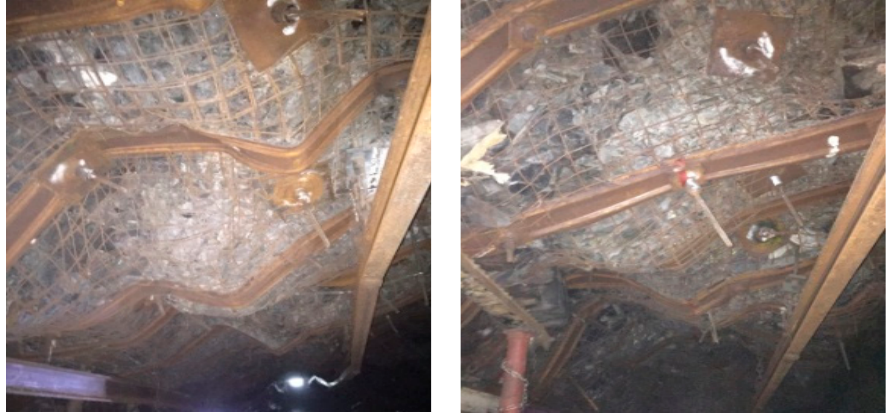
Figure 3. Deformation and failure characteristics of the roadway.